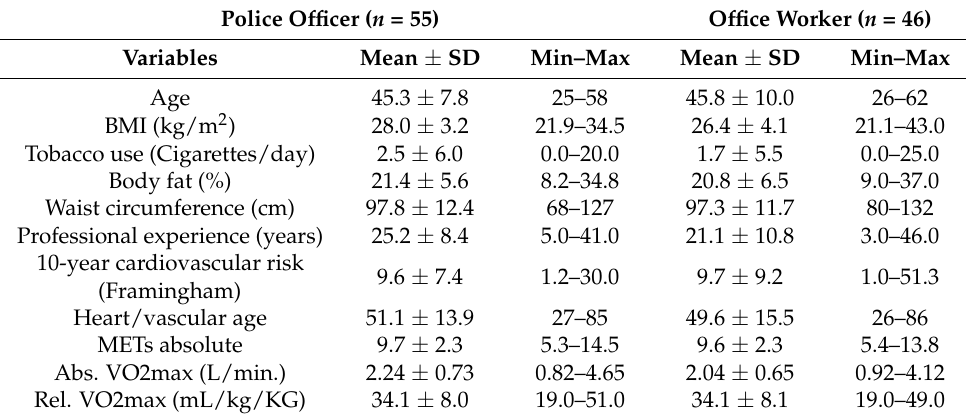
Table 1. Baseline characteristics of the